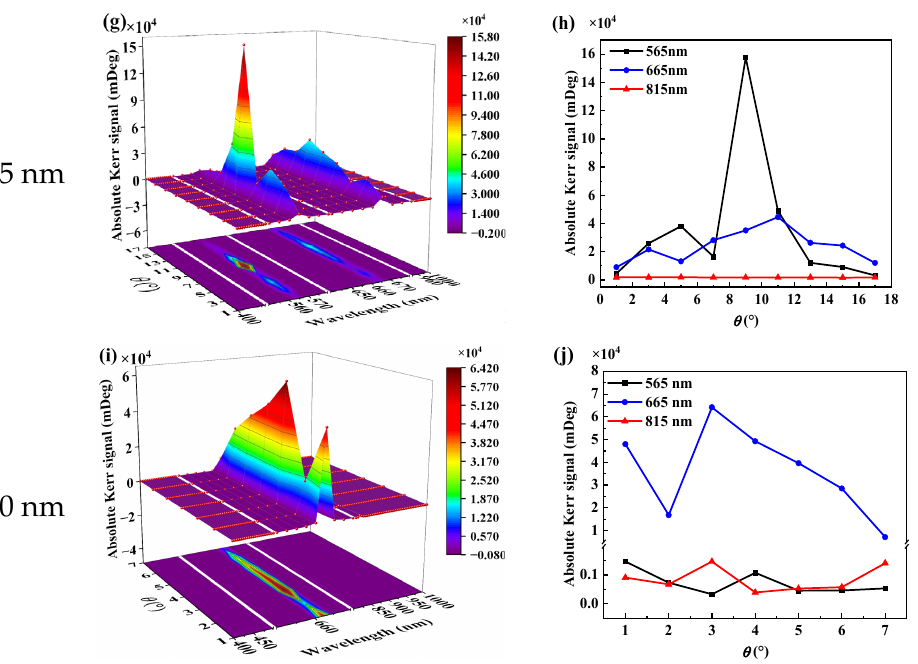
Figure 5. Wavelength dependence of PMOKE response for the Au bowties of different θ and side length placed at center of the magnetic layer (the side length is indicated in the legend). ( a , c , e , g , i ) indicate the change rule in PMOKE with θ under 400–1000 nm incident wave when the side length changes from 100 nm to 200 nm every 25 nm. ( b , d , f , h , j ) denote the change rule in PMOKE of the structure with θ under three resonant wavelengths (565 nm, 665 nm, and 815 nm). It can be seen in Figure 5 that increasing θ results in a signal augmentation for the PMOKE with the same side length. The maximal signal is greater than that of the structure without the rotation angle. The rotation angle does not affect the structure’s resonant wavelength. The structure’s resonant signal achieves its maximum value when a = 150 nm, θ = 19° (Figure 5f, red line), which is 2.3 times stronger than the structure without rotation angle at the same side length, and 3255 times stronger than the magnetic film